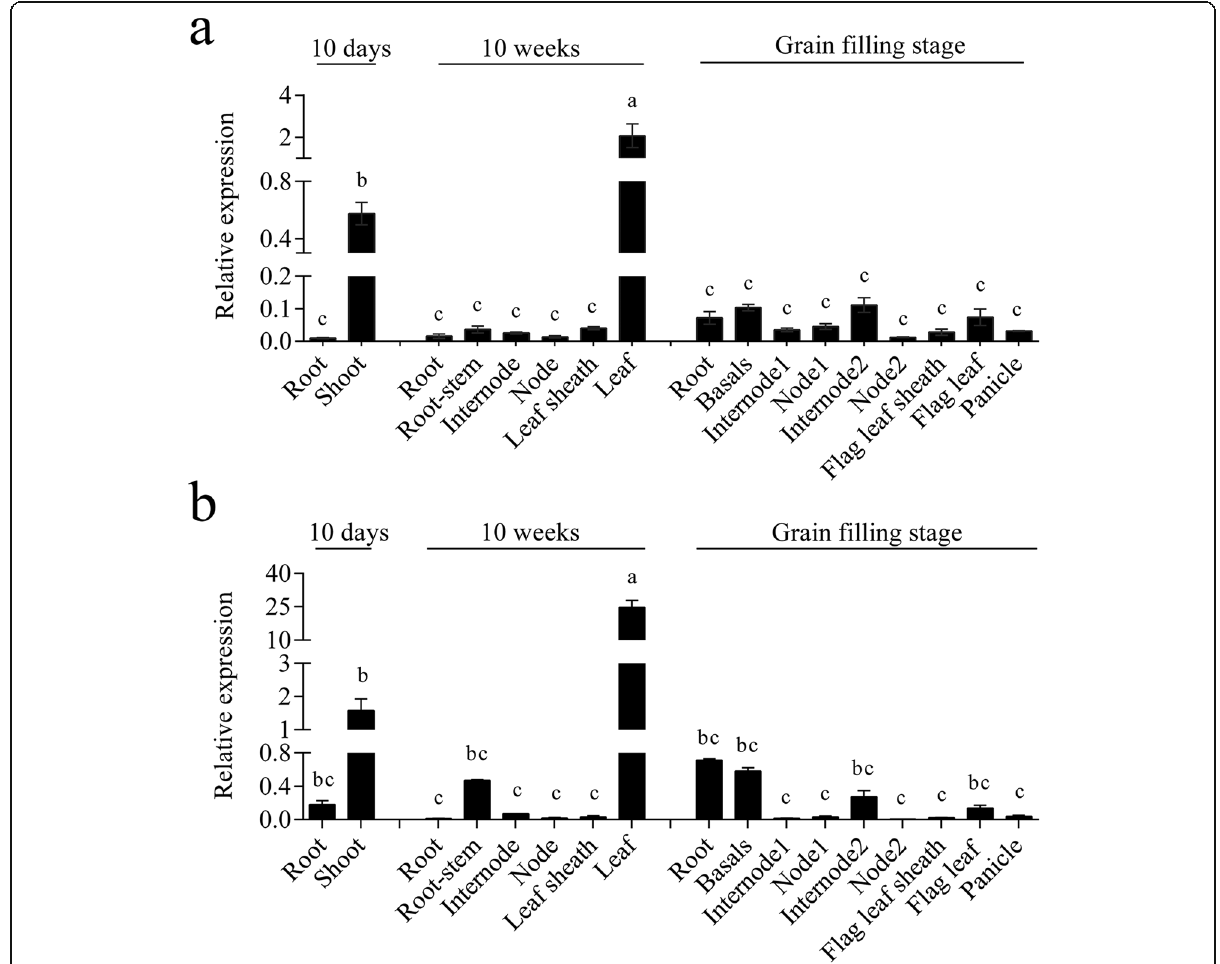
Fig. 6 Spatial and temporal expression of OscpSRP54a and OscpSRP54b . a Relative expression levels of OscpSRP54a in various tissues of IR64 at different growth stages; b Relative expression levels of OscpSRP54b in various tissues of Kitaake at different growth stages. Different letters indicate significant differences according to One-way ANOVA and Duncan ’ s test ( p ≤